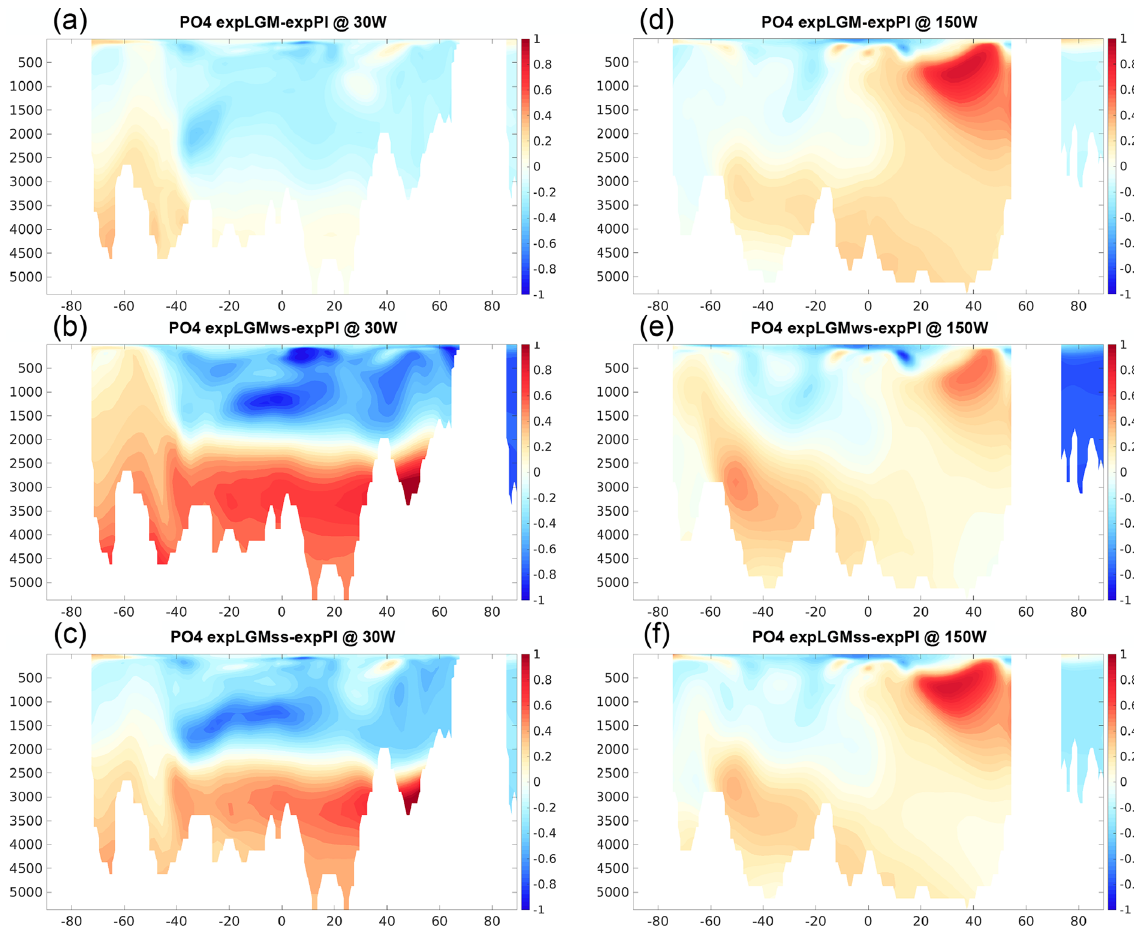
Figure 6. Meridional sections in the Atlantic ( a–c ; at 30 ◦ W) and in the Pacific ( d–f ; at 150 ◦ W) of the simulated phosphate concentrations in the LGM experiments (mmolm − 3 ): expLGM (a, d) , expLGMws (b, e) , and expLGMss (c, f) . The differences between each LGM experiment and expPI are shown. The average states of the last 50 years are